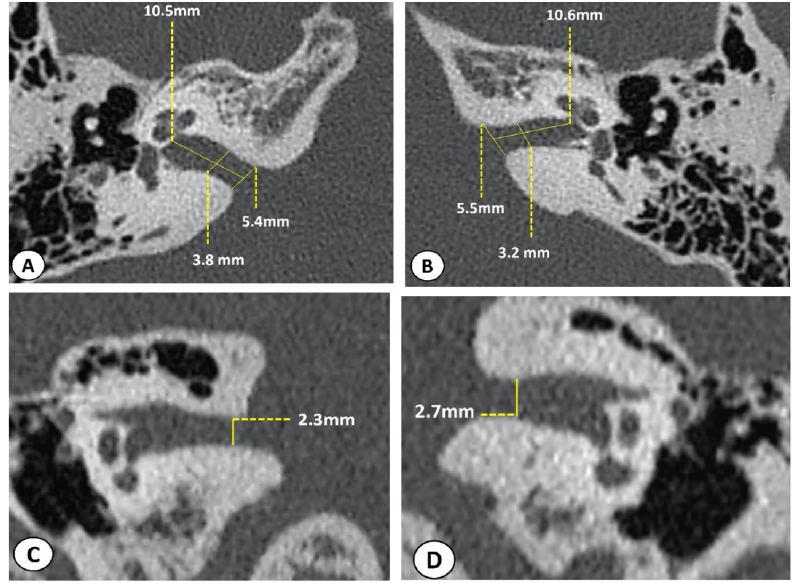
Figure 2. HRCT of temporal bones (IAC sections) confirming a bilateral narrowing of the IAC, in the coronal plane, more pronounced on the right side: ( A ) right ear, axial plane; ( B ) left ear, axial plane; ( C ) right ear, coronal plane; and ( D ) left ear, coronal plane.